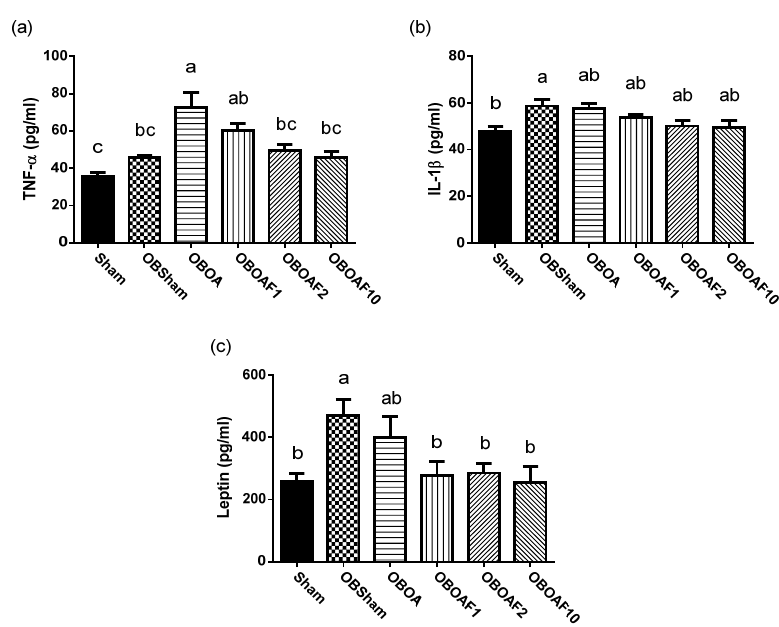
Figure 3. The effect of fucoidan treatment on plasma cytokines in HFD-induced obese male rats with ACLT + MMx surgery induced OA. ( a ) Plasma tumor necrosis factor (TNF)- α ; ( b ) Interleukin (IL)-1 β . ( c ) Leptin. The data are the concentrations of each cytokine, expressed as the mean ± S.E.M ( n = 7). The values with different superscript letters, “a” and “b”, represent significant differences ( p < 0.05) via one-way ANOVA followed by Duncan’s multiple range tests.